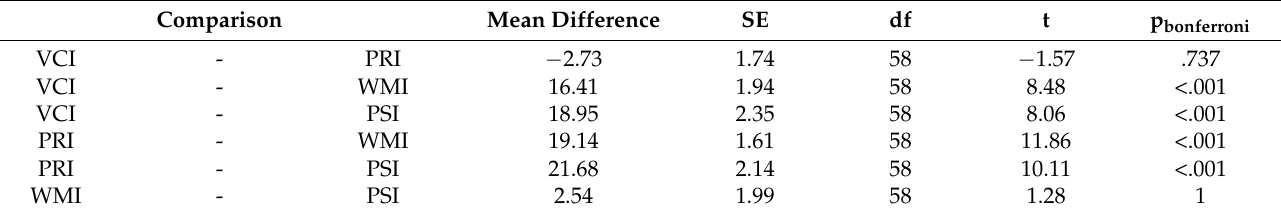
Figure 1. The cognitive profile of Moderately Gifted and Gifted children using ( a ) WISC ‐ IV primary indices; ( b ) WISC ‐ IV supplementary indices. Whiskers represent the 95% confidence interval (CI), and circles represent the average score obtained by the sample. Table 3. Bonferroni ‐ corrected post hoc tests comparing the WISC ‐ IV primary indices. Comparison